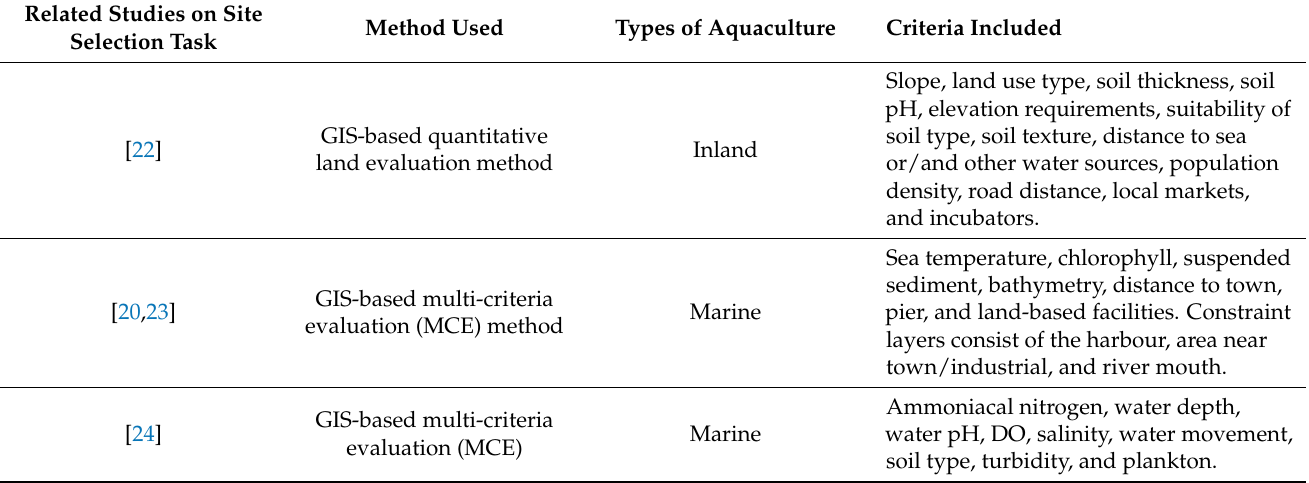
Table 1. Summary of previous studies on aquaculture site selection